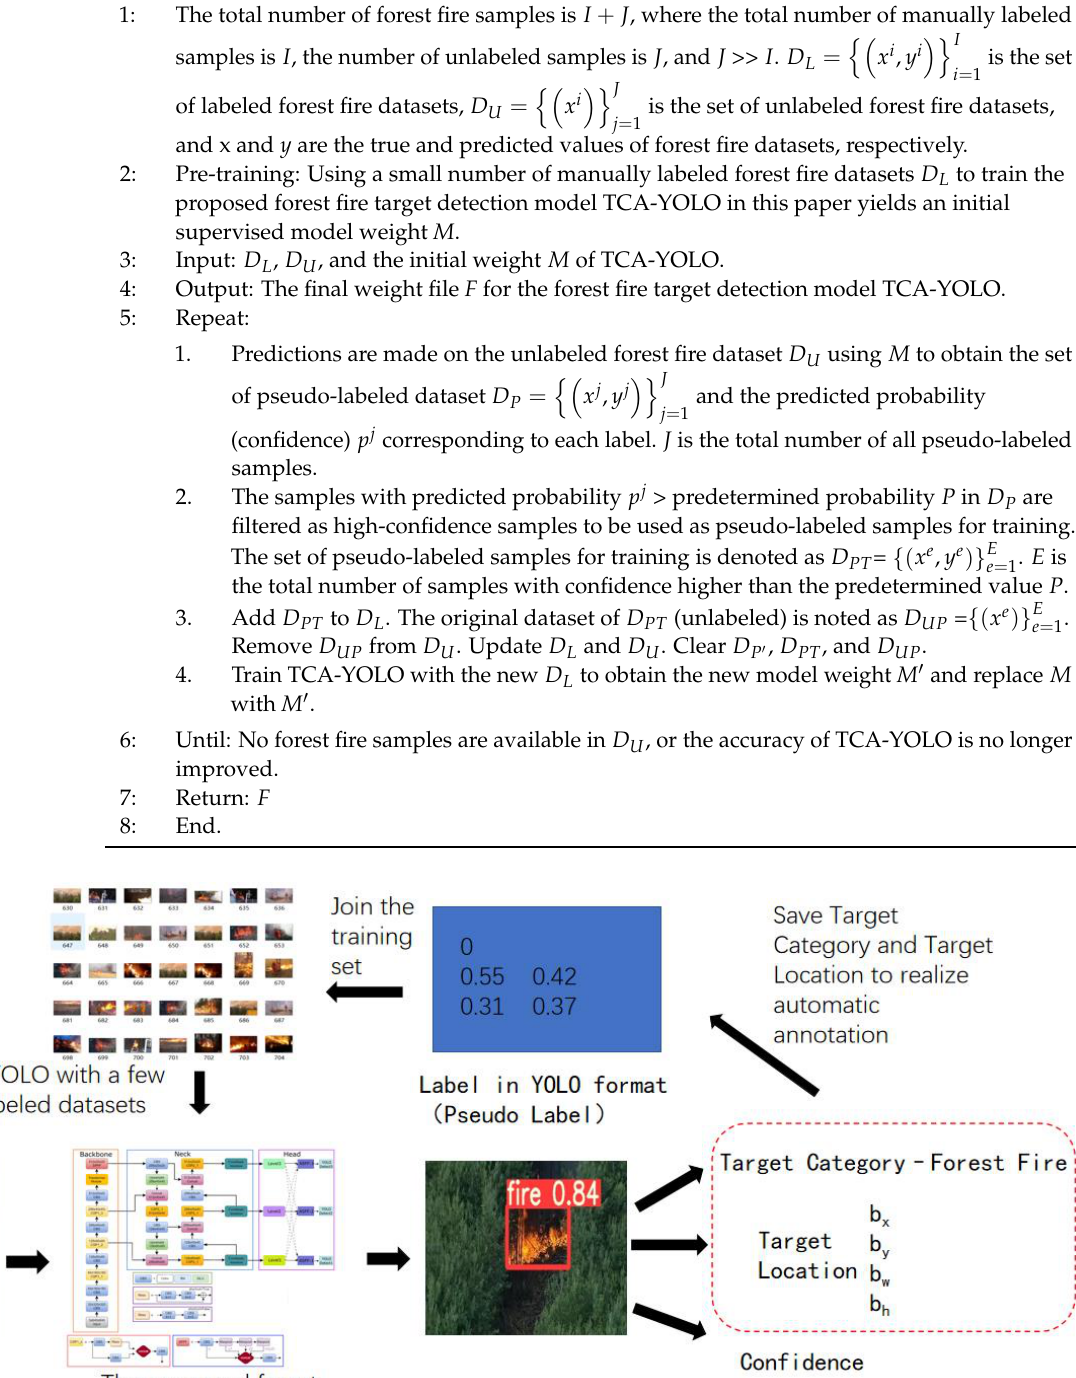
Algorithm 1: The semi-supervised algorithm for training